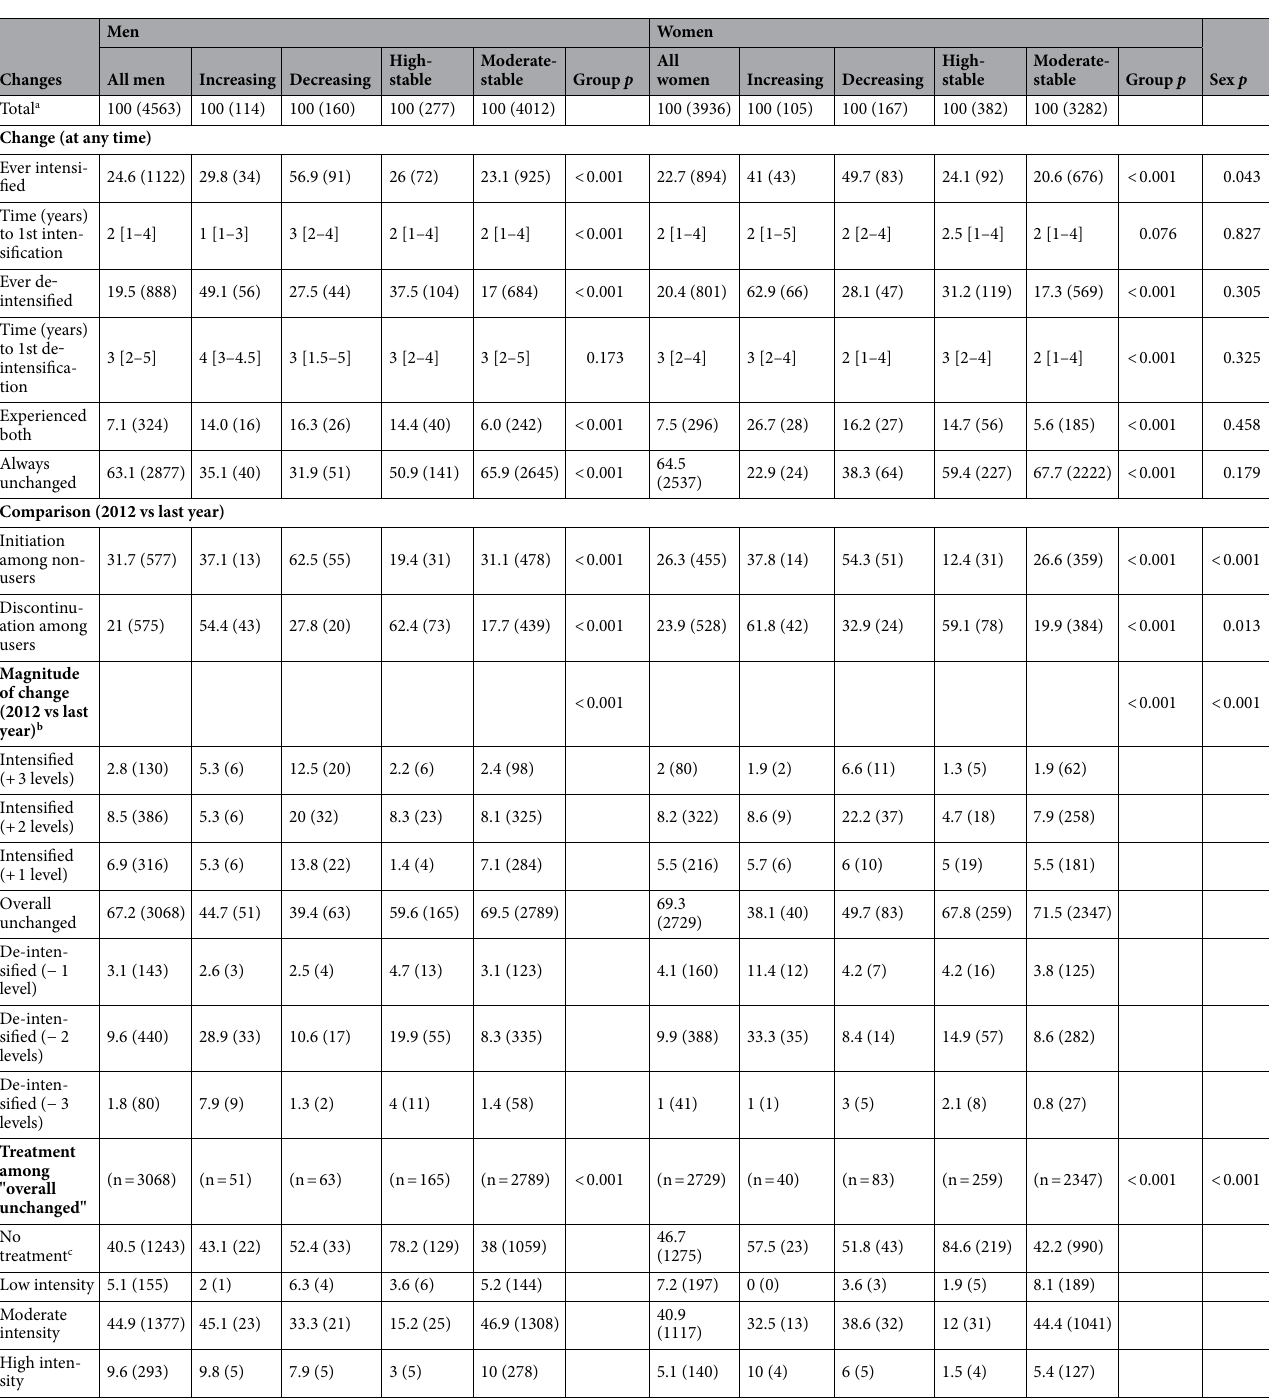
Table 3. Change in statin therapy between baseline (2012) and last year of follow-up by trajectory group for men and women. Values are expressed as % (n) for categorical variables, mean ± SD or median [interquartile range] for continuous variables. p value comparisons across trajectory groups and sex are based on χ 2 test for categorical variables and Kruskal–Wallis test for continuous variables. a Patients who died or moved outside of the study region during 2013 (n = 99) were excluded from this analysis so that a patients’ last year of follow-up varied between 2013 and 2017. b Graded treatment change (intensified or de-intesified) of 3 levels (change between "no treatment" and "high-intensity"), 2 levels (change between "no treatment" and "moderate-intensity", or between "low-" and "high-intensity"), and 1 level (change between "no treatment" and "low-intensity", between "low-" and "moderate-intensity", or between "moderate-" and "high-intensity"). c Other lipid-lowering treatment was used by ≤ 1.2% (men: ≤ 1.1%, women: ≤ 1.6%) of the patients with “overall unchanged” no statin